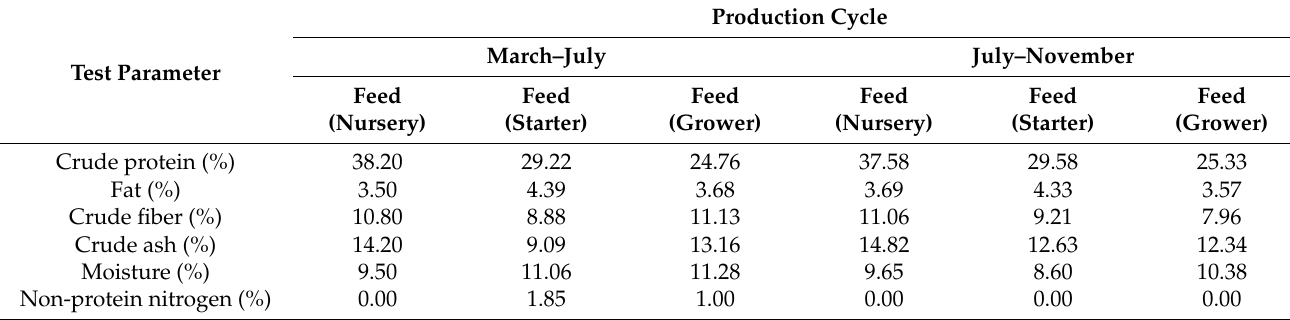
Table 1. Feed types and their nutritional